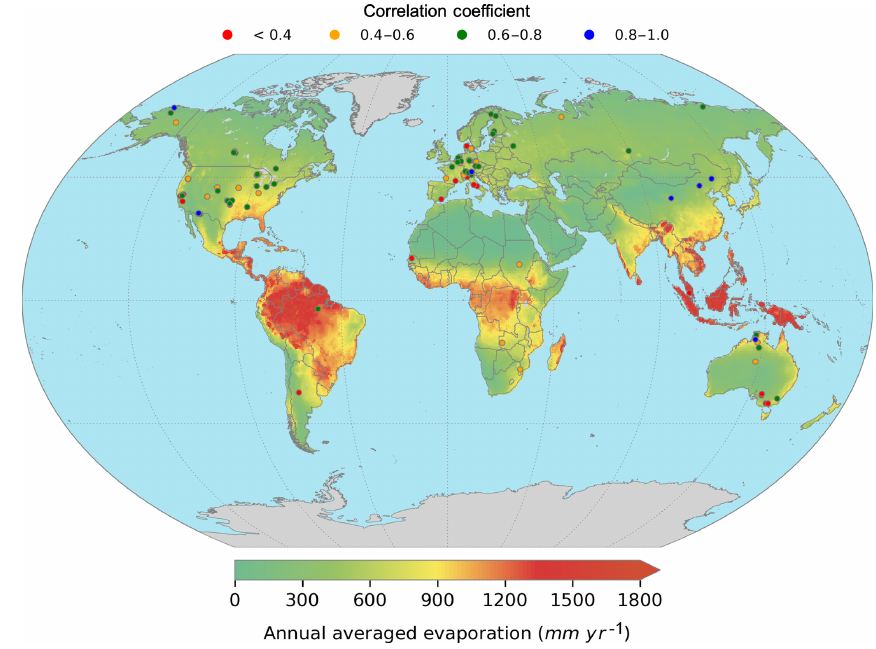
Figure 6. Averaged monthly evaporation of the WAYS simulation (WAYS_CRU) against the FLUXNET data.